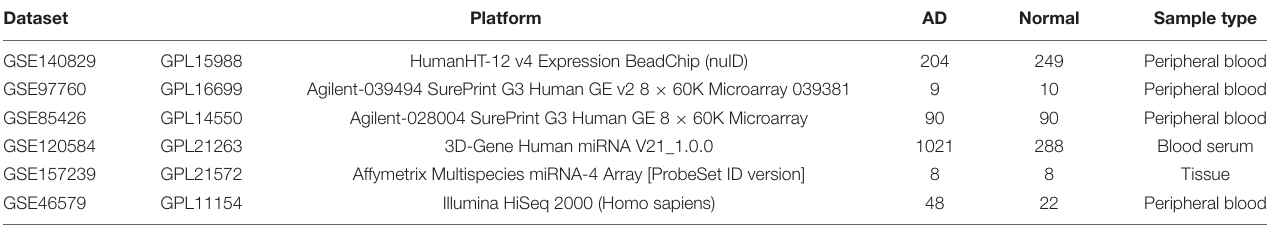
TABLE 1 | Information of GEO datasets. Dataset Platform AD